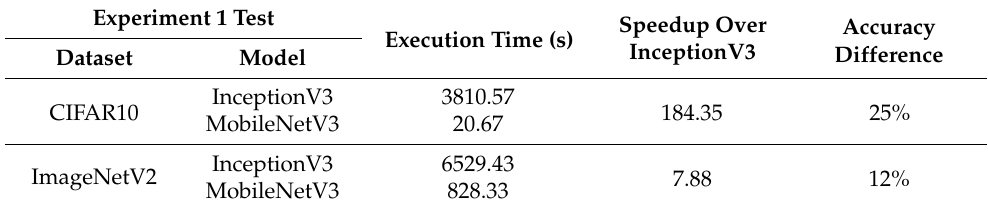
Table 11. Accuracy and speedup differences over InceptionV3 using MobileNetV3 for Configuration 1.